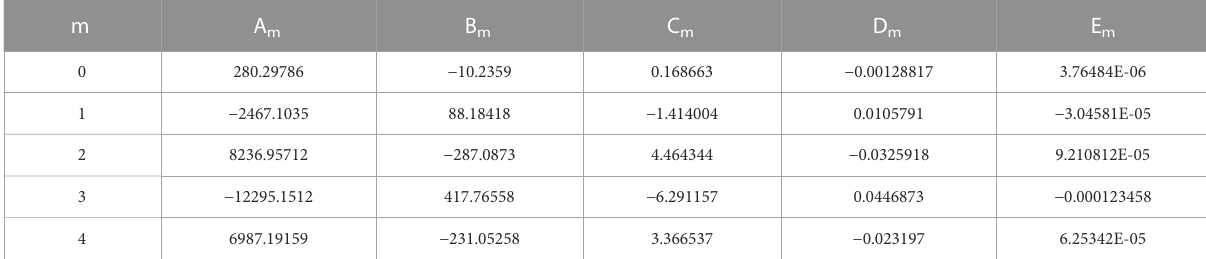
TABLE 3 Viscosity model coef fi cients of LiBr (Jia, 2002).